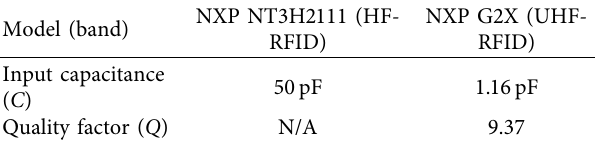
Table 1: Characteristics of RFID IC chips.